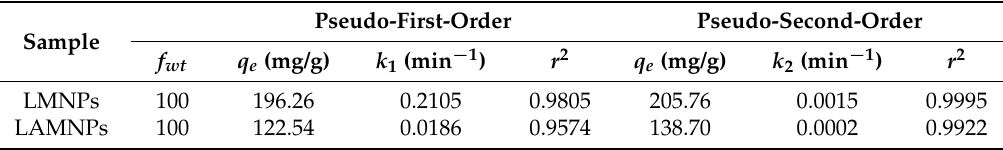
Table 5. Kinetic model parameters for LMNPs and LAMNPs.